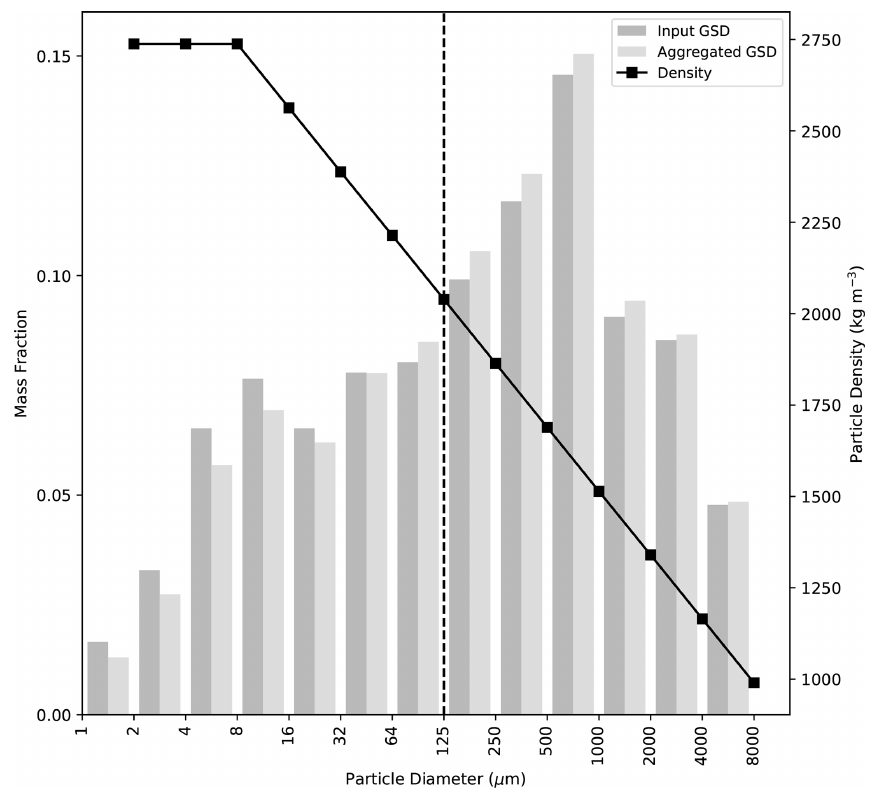
Figure 7. The GSD of the Eyjafjallajökull (2010) non-aggregated tephra (dark grey bars; from Bonadonna et al., 2011), used to initialize the aggregation scheme, and the modelled aggregated GSD at the top of the plume (light grey bars), at 19:00UTC on 4 May 2010. The density distribution of the non-aggregated particles, taken from Bonadonna et al. (2011), is also shown. Table 5. Input parameters for the NAME